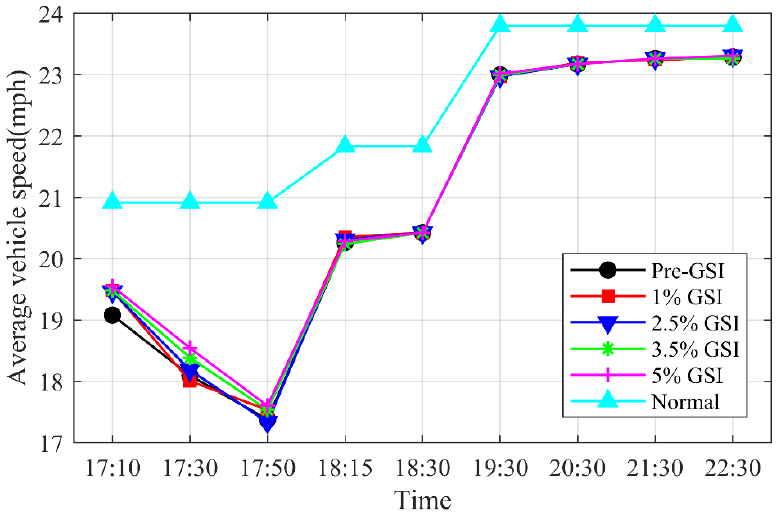
Figure 10. Average vehicle speed of Normal (no weather effects), pre-GSI, and GSI scenarios over the simulation time.